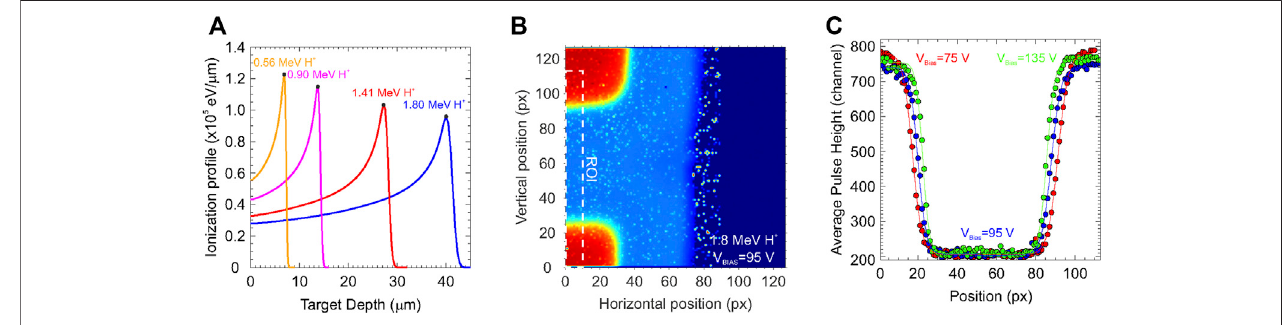
FIGURE 4 | (A) Ionization pro fi les for 4 proton energies used to measure the interpad gap distance. (B) IBIC areal scan (175 × 175 μ m 2 ) for sample A obtained by 1.8 MeV protons and 95 V bias. (C) CCE pro fi les for 1.8 MeV protons between the two active pixels fi tted by an error function for 3 different